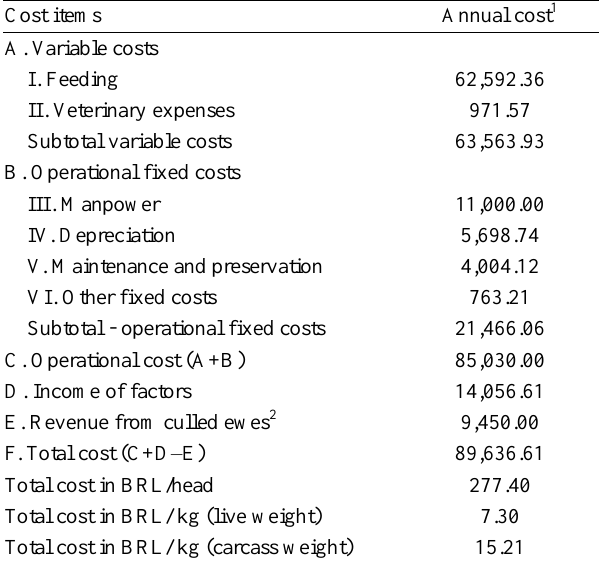
Table 2. Annual costs for the production of meat